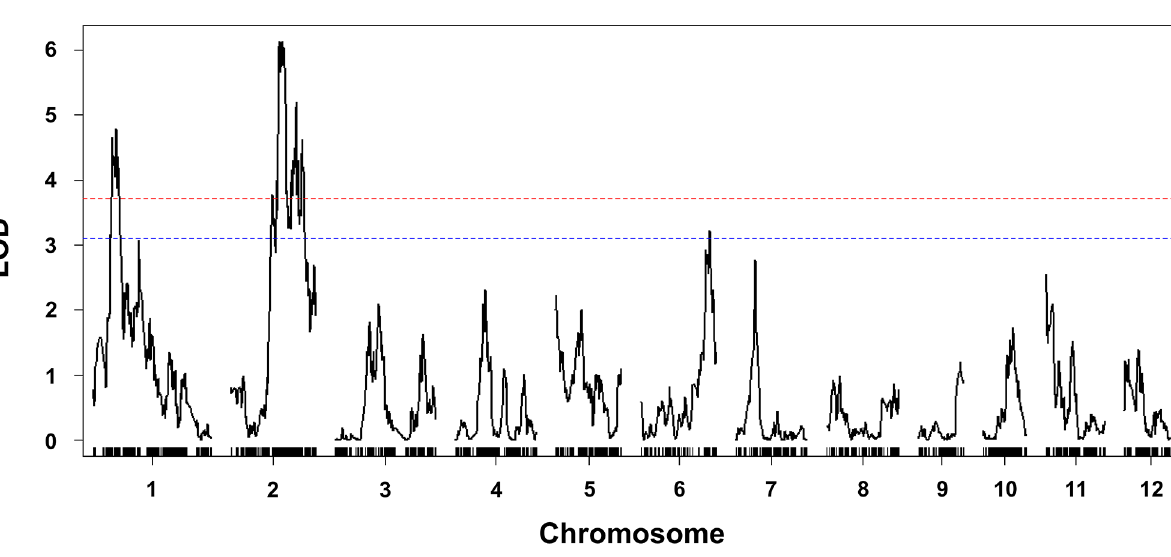
Fig. 3 Linkage mapping in the population of 166 recombinant inbred lines (RILs) derived from ‘TK16’ × ‘Budda’. The horizontal line represents the loga- rithm of odds (LOD) thresholds at 95% (blue) and 99% (red) confidence level based on 1000